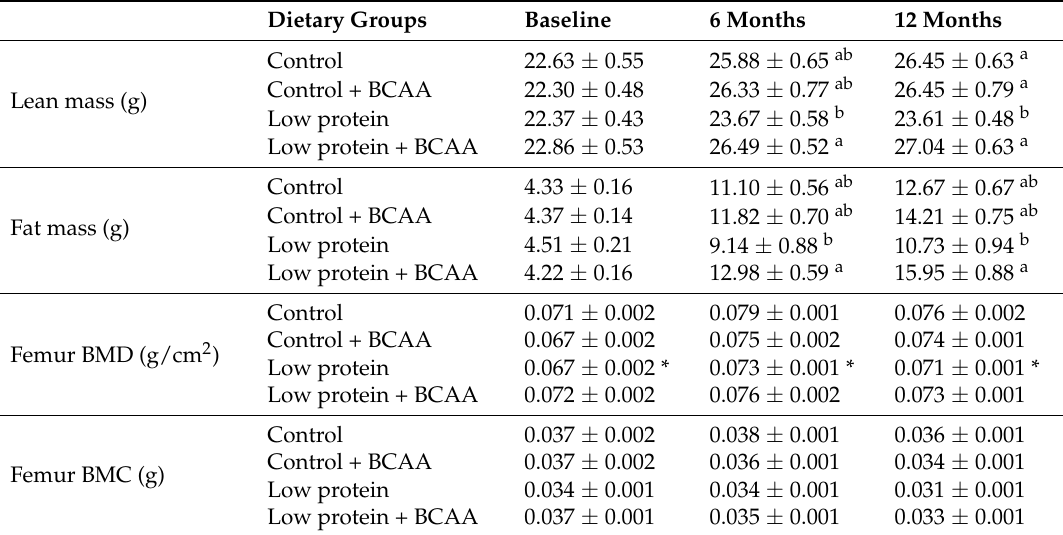
Table 3. Body composition and bone mineral